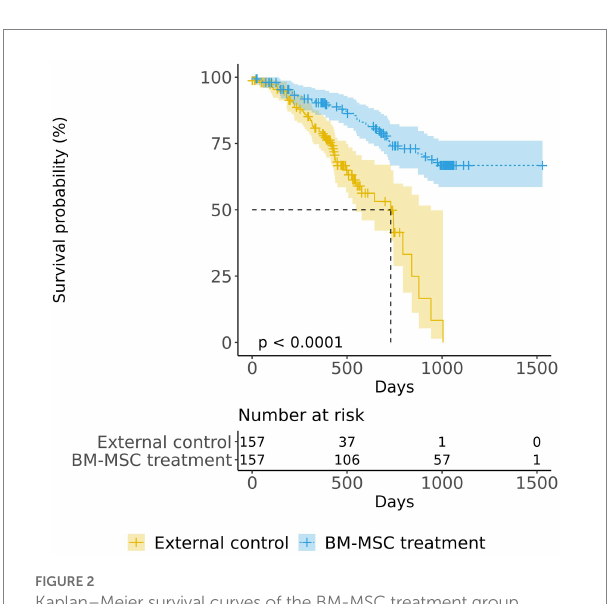
FIGURE 2 Kaplan–Meier survival curves of the BM-MSC treatment group (overall) and the external control group. The log-rank test was used to compare the survival probability between the BM-MSC treatment (blue) and the external control (yellow)